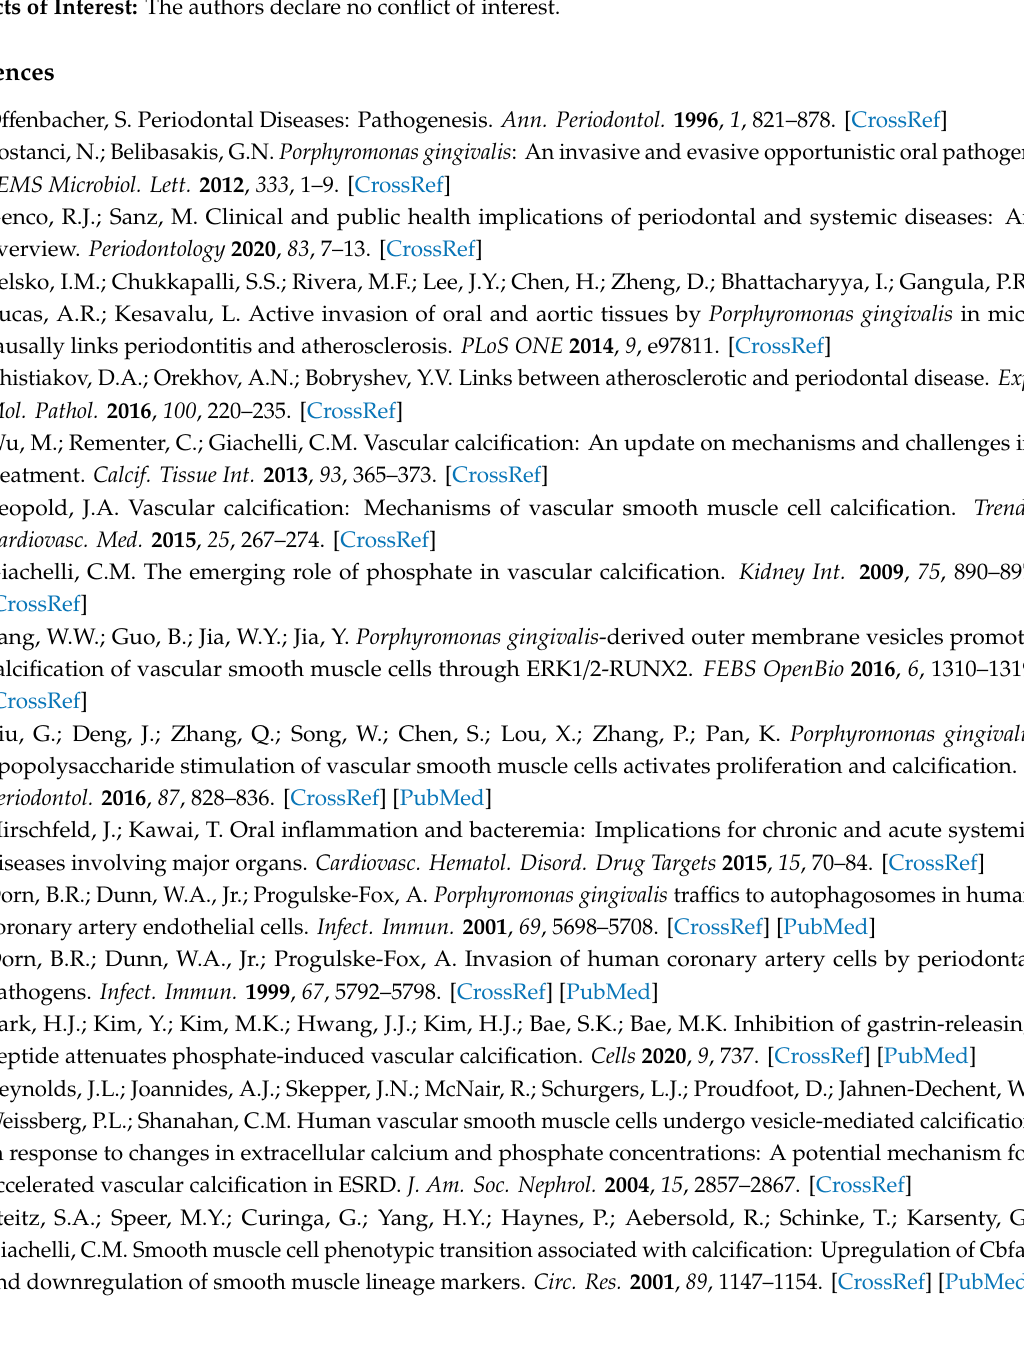
Figure S1: E ff ect of P. gingivalis infection in A7r5 cells, Table S1: Primer sequences for real-time